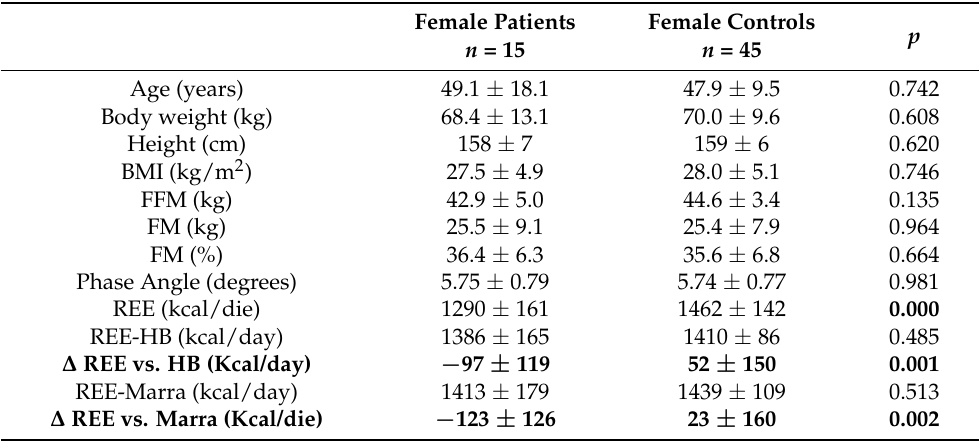
Table 4. Body composition and resting energy expenditure (measured and estimated) of female GD1 patients ( n = 15) compared to female healthy controls ( n =